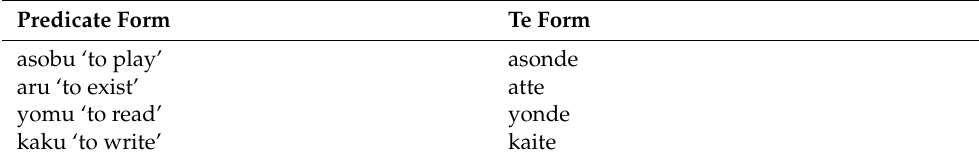
Table 12. Japanese predicate form and -te form.